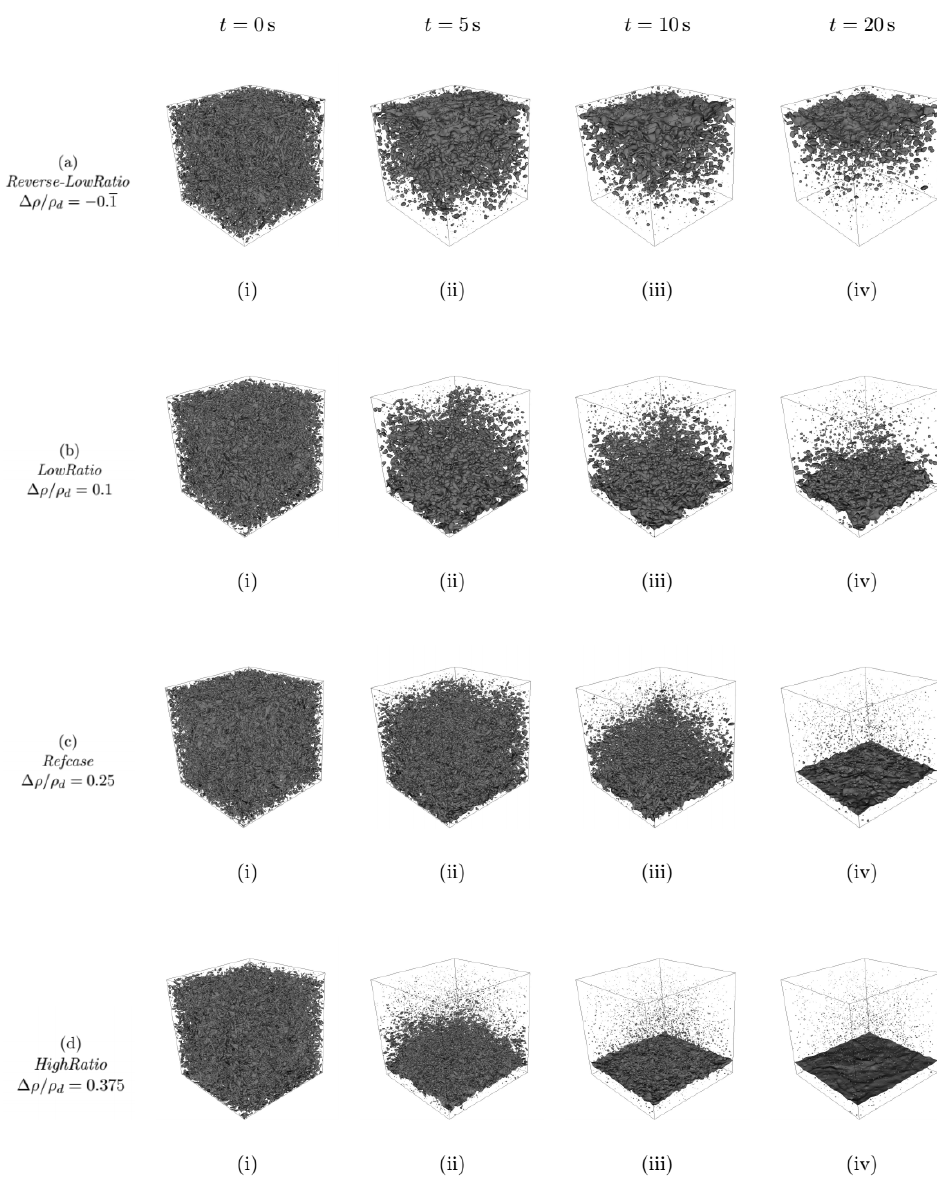
Figure 6. Visualization of the segregation process for varying ∆ ρ / ρ d . The rows correspond to the considered configurations: ( a ) Reverse-Low Ratio , ( b ) Low Ratio , ( c ) Refcase , ( d ) High Ratio . The columns correspond to four different time instants subsequent to the start of segregation: (i–iv) corresponds to t = { 0,5,10,20 } s,